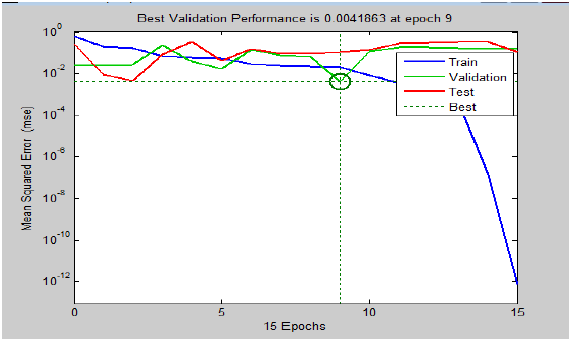
Fig. 1. Performance graph showing the training, validation, test and best performance after nine epochs for the artificial neural network when using term weight metrics values to implement an information fusion